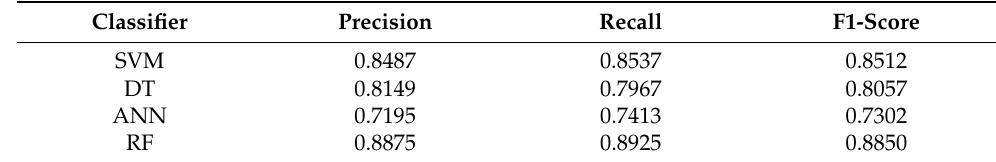
Table 4. Comparison of testing performance of four machine learning algorithms in geological